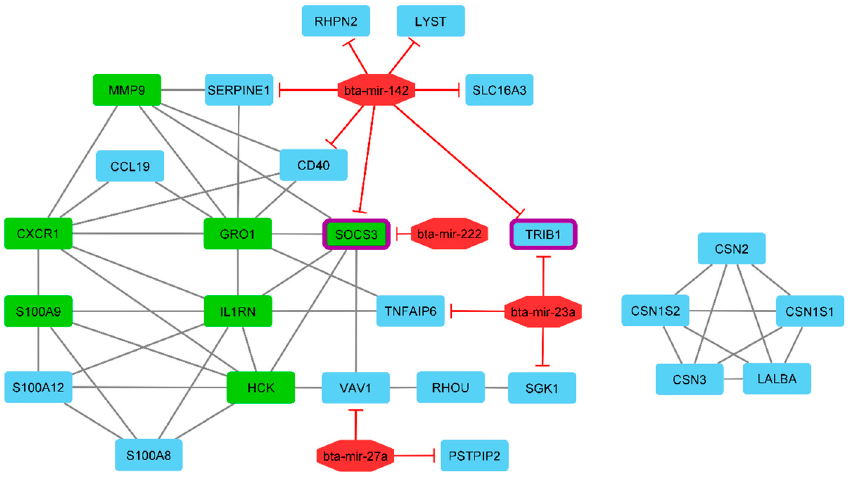
Figure 5. Interactive bipartite network (gene–miRNA) which demonstrates the regulatory effect on mastitis in dairy cattle. In this network, the quadrilateral points represent genes, and the octagonal points represent miRNAs. Regarding miRNAs and target genes, the edges indicate the suppressive role of miRNAs. The edges also represent the gene–gene interactions. The green quadrilateral nodes represent the hub genes. The quadrilateral nodes that have purple around them are the genes showing the highest suppression by miRNAs.